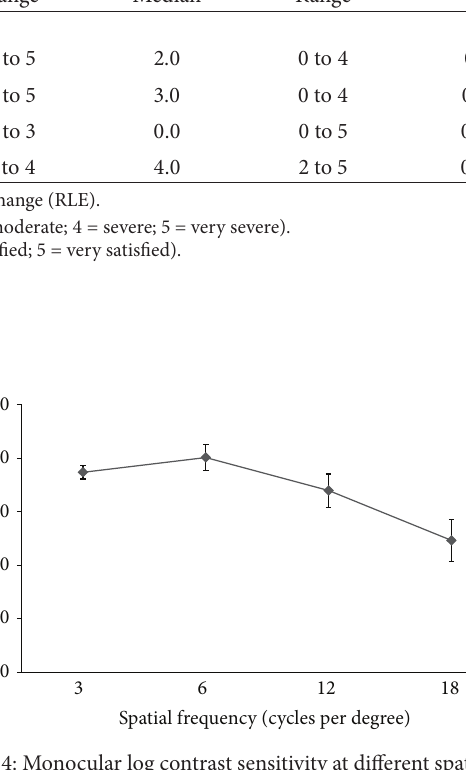
Figure 4: Monocular log contrast sensitivity at different spatial fre- quencies at 6 months. The error bar represents the 95% confidence interval of the